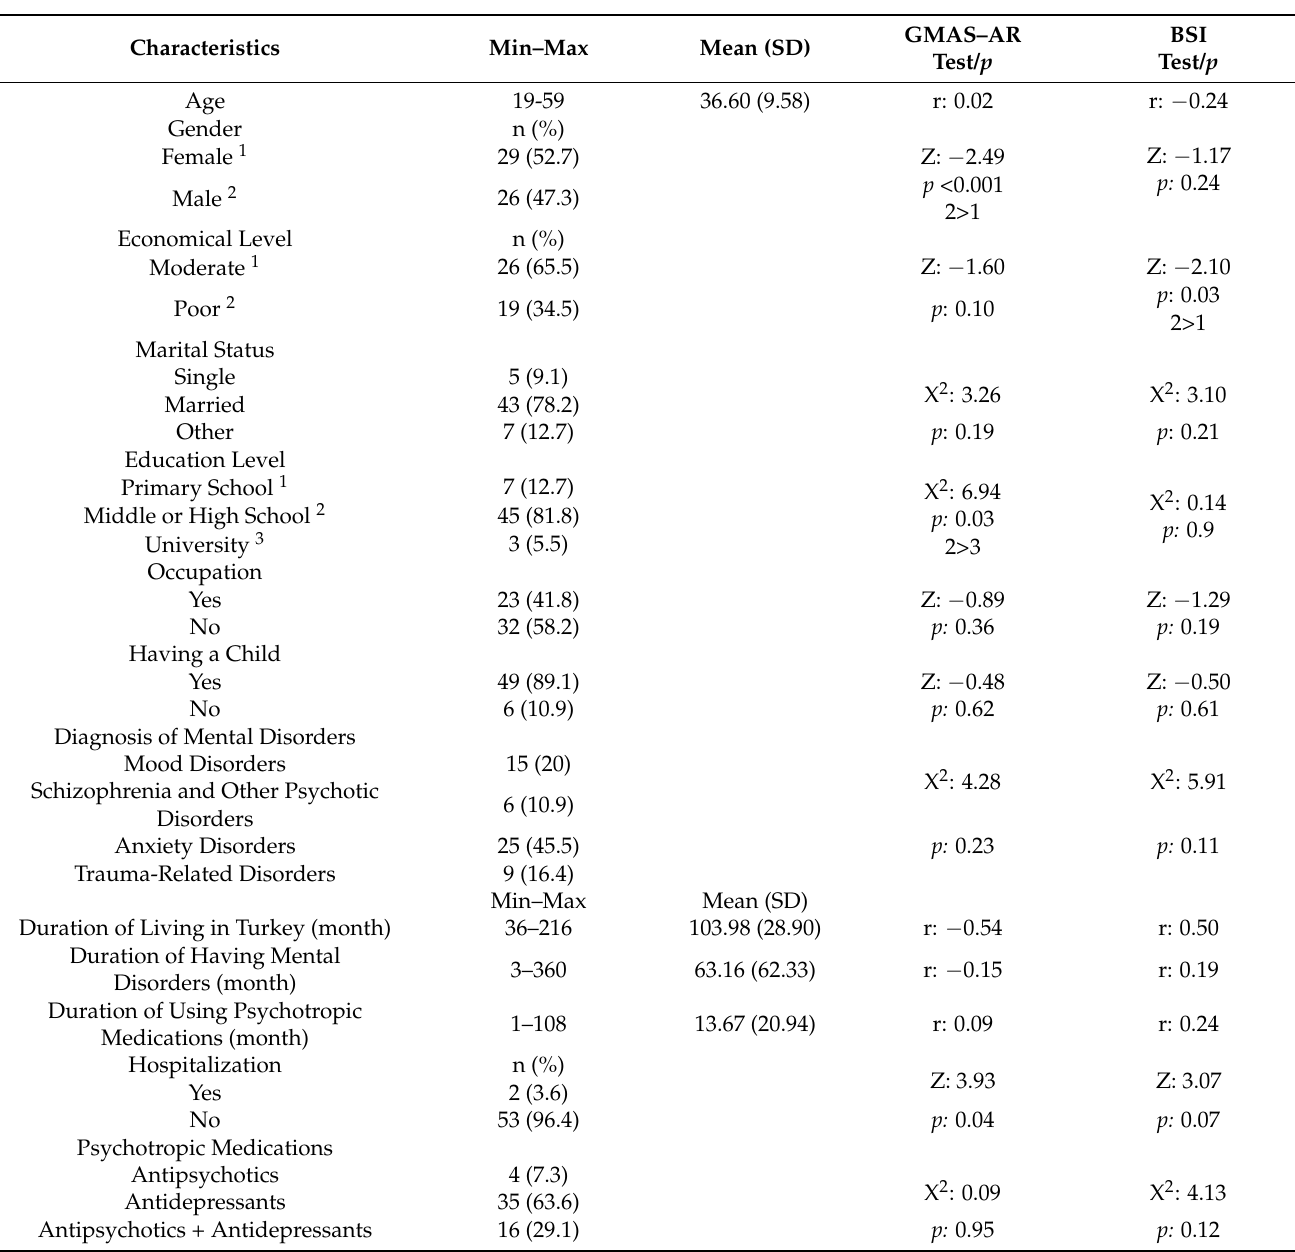
Table 1. Sociodemographic Characteristics of Participants and Comparing GMAS–AR and BSI Total Mean Scores According to These Characteristics.